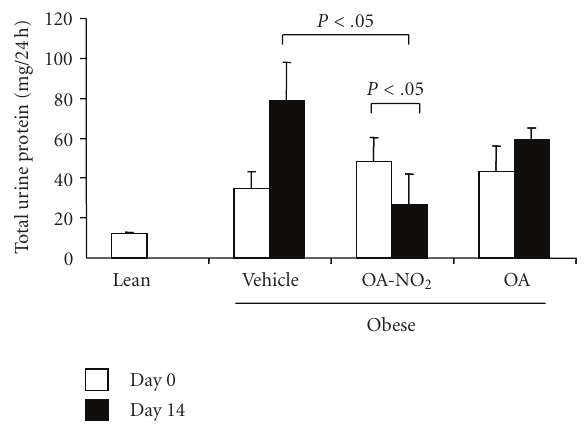
Figure 8: Proteinuria in obese Zucker rats before and after 14- d infusion with vehicle, OA-NO 2 , or OA. Lean rats with vehicle treatment were used as controls. Lean: n = 3; Vehicle: n = 7; OA- NO 2 : n = 5; OA: n = 5. Data are mean ± SE.